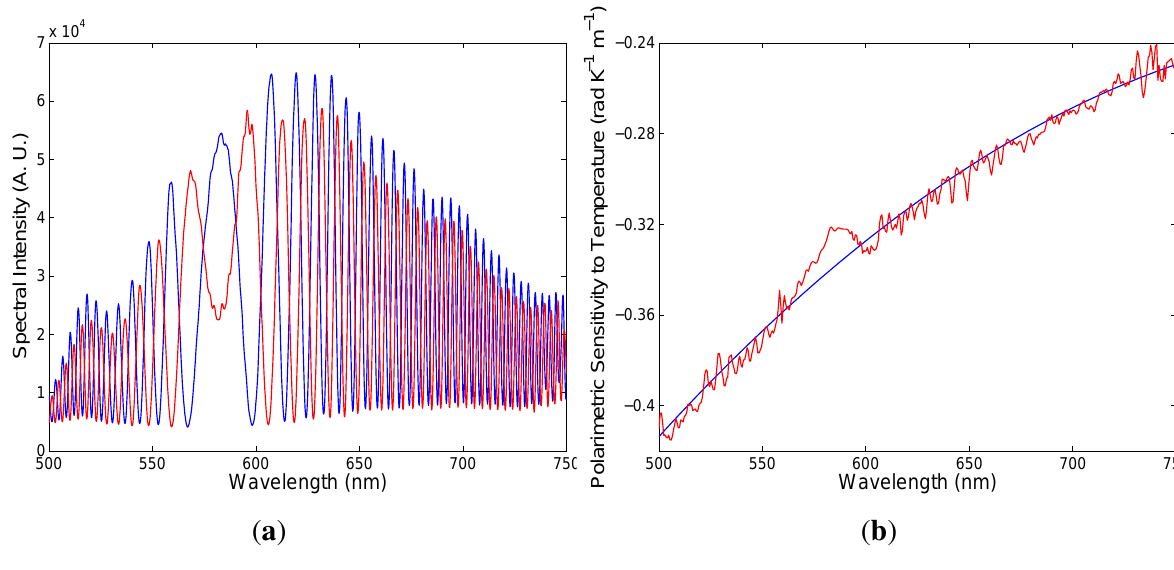
Figure 8. Two recorded spectra corresponding to temperatures T T = 333 K (red) ( a ). The spectral dependence of the polarimetric sensitivity to temperature 2 ( b ). The line is the approximate quadratic